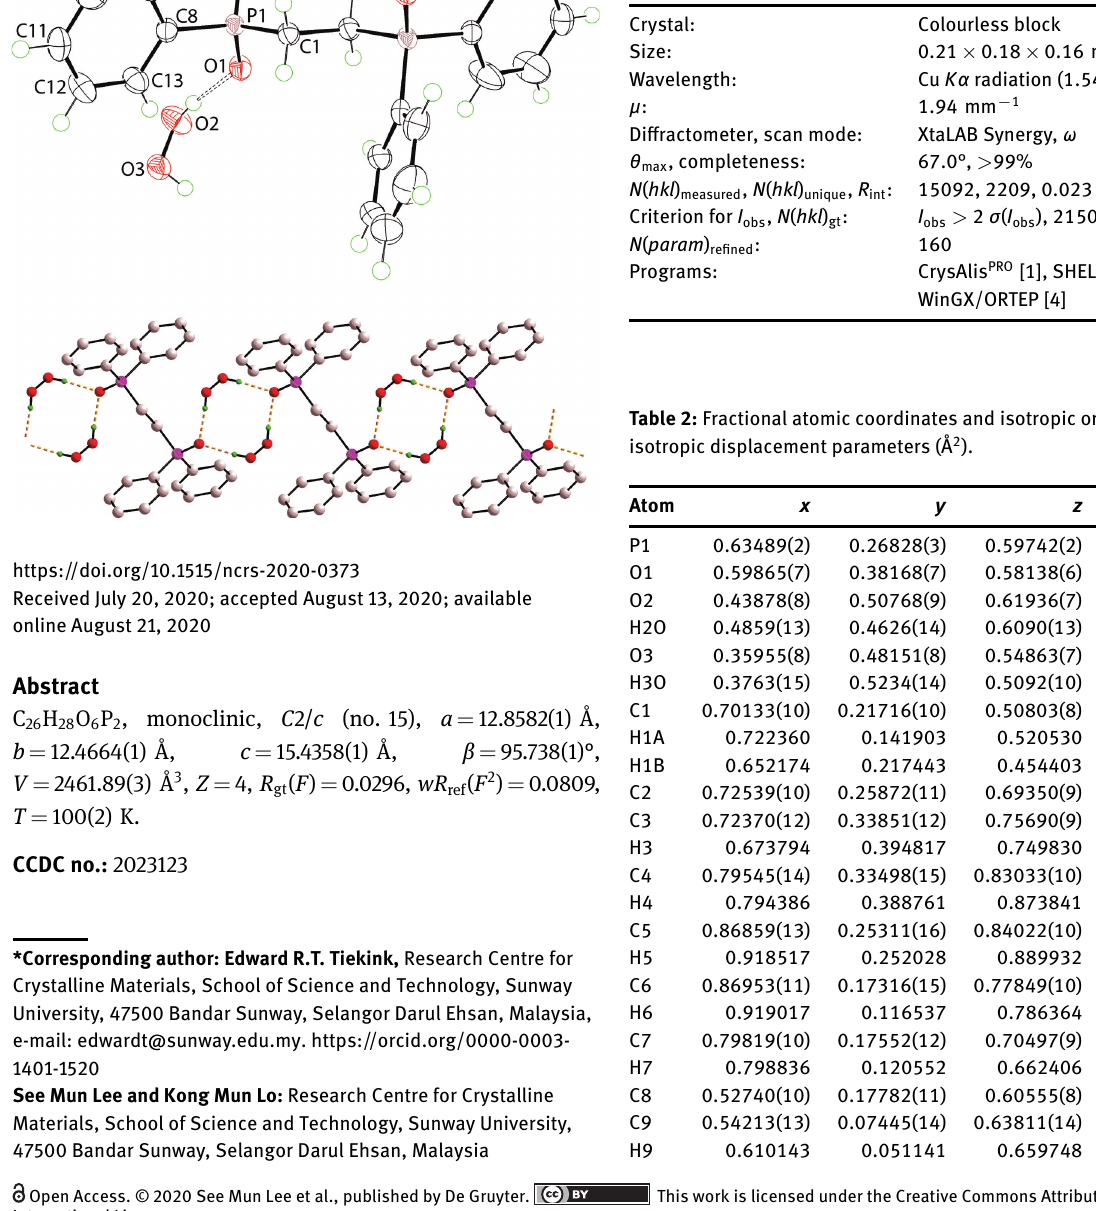
Table 1 contains crystallographic data and Table 2 contains the list of the atoms including atomic coordinates and dis- placement parameters. Table 1: Data collection and handling.